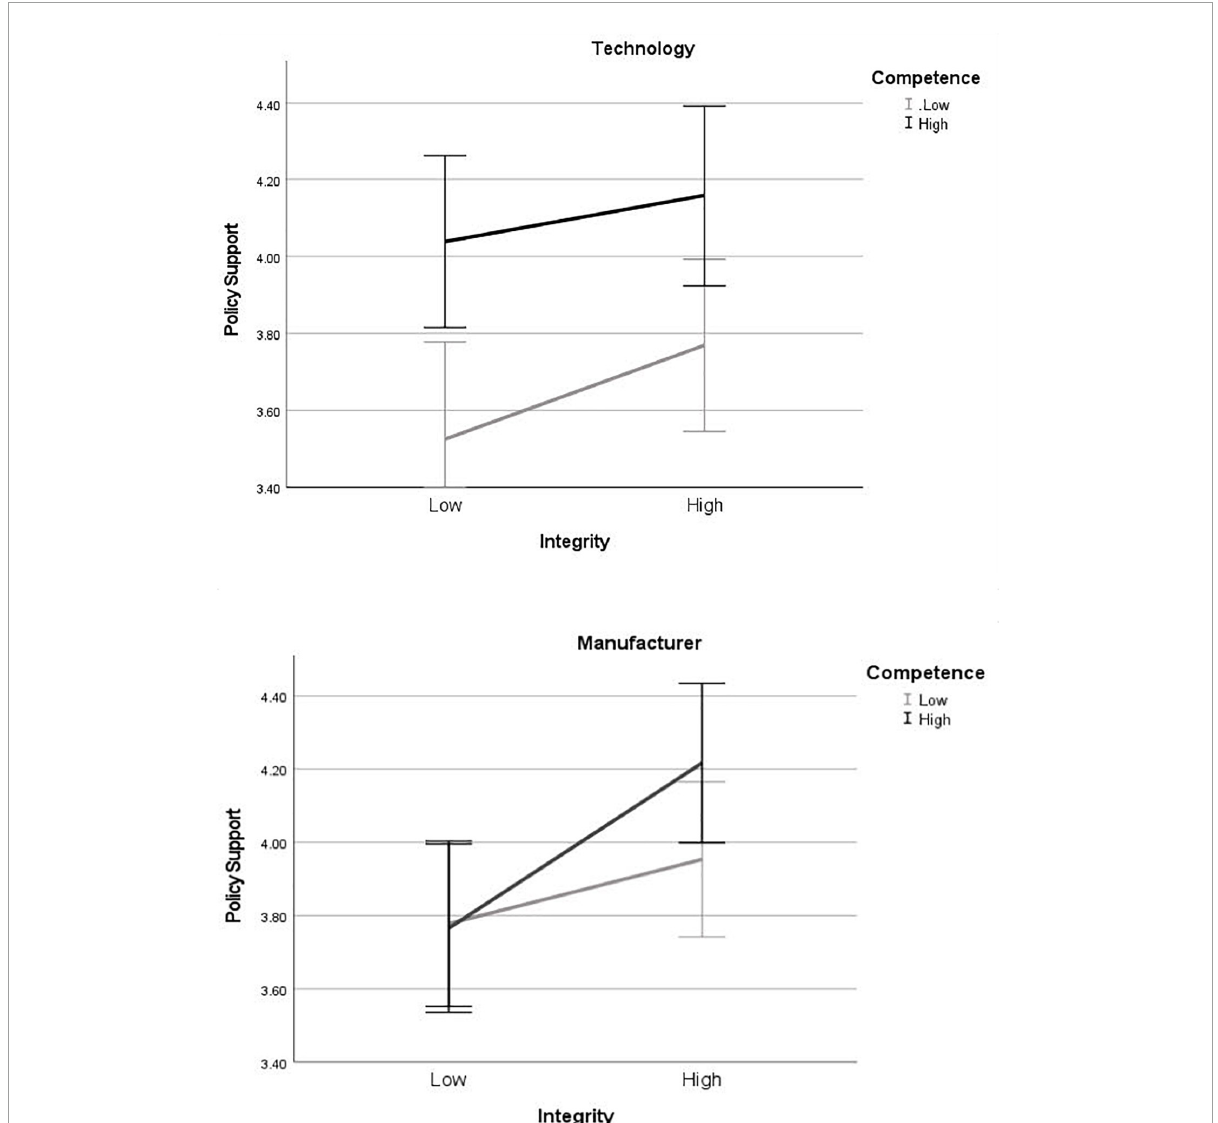
FIGURE1 Study 3 policy support ratings for messages about the autonomous vehicle (AV) technology (top) and manufacturers (bottom) . Error bars show 95% confidence intervals.